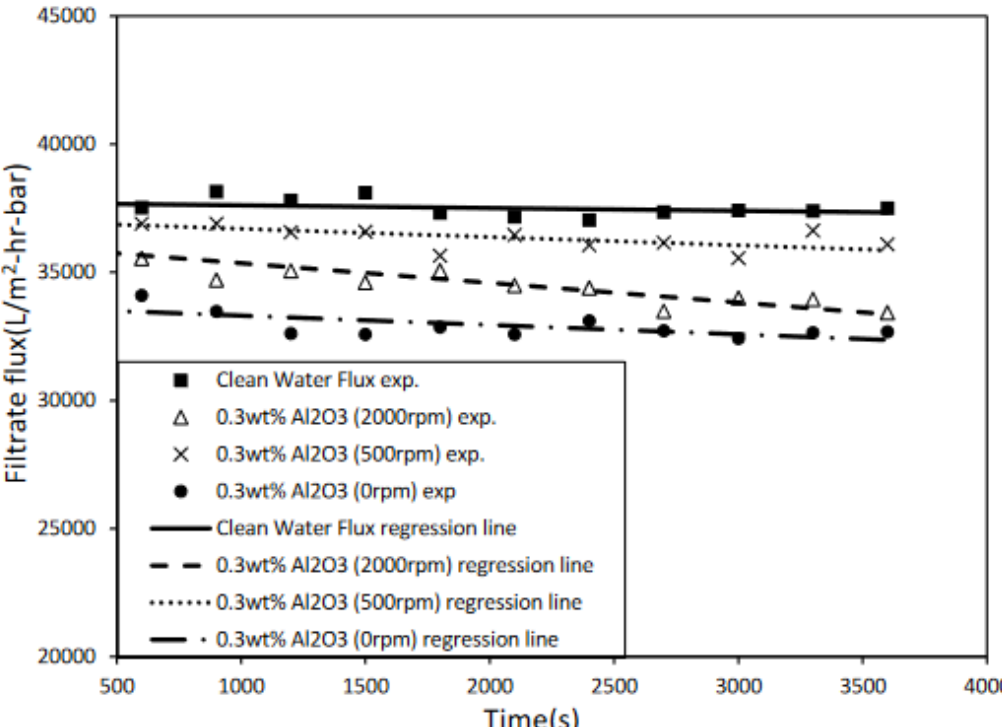
Figure 8. Filtrate flux rate at different centrifugal chamber rotation speeds.